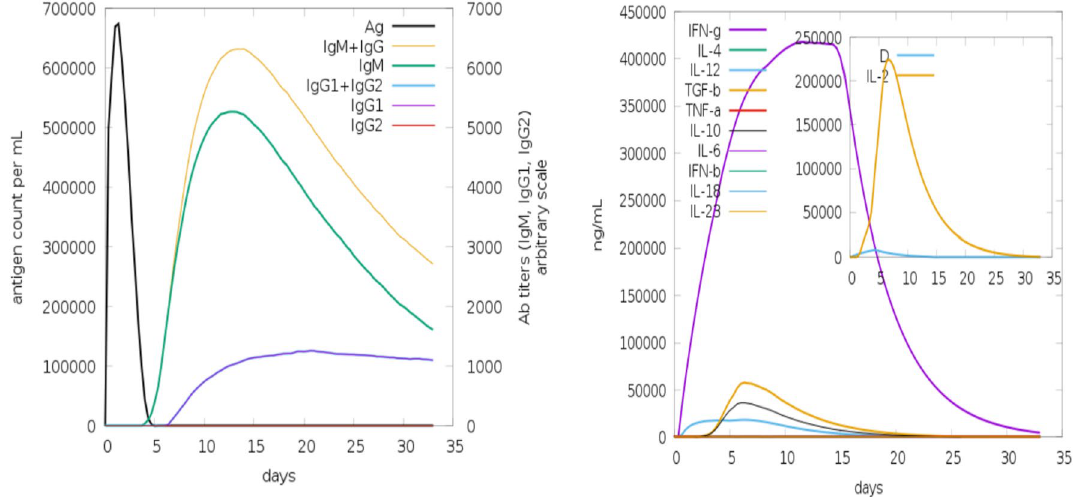
Figure 8. C-immune simulation to verify the host immune system’s reaction against the polyepitope-based vaccine engineered. At the left there are antibodies, whereas cytokines and interleukins are shown in